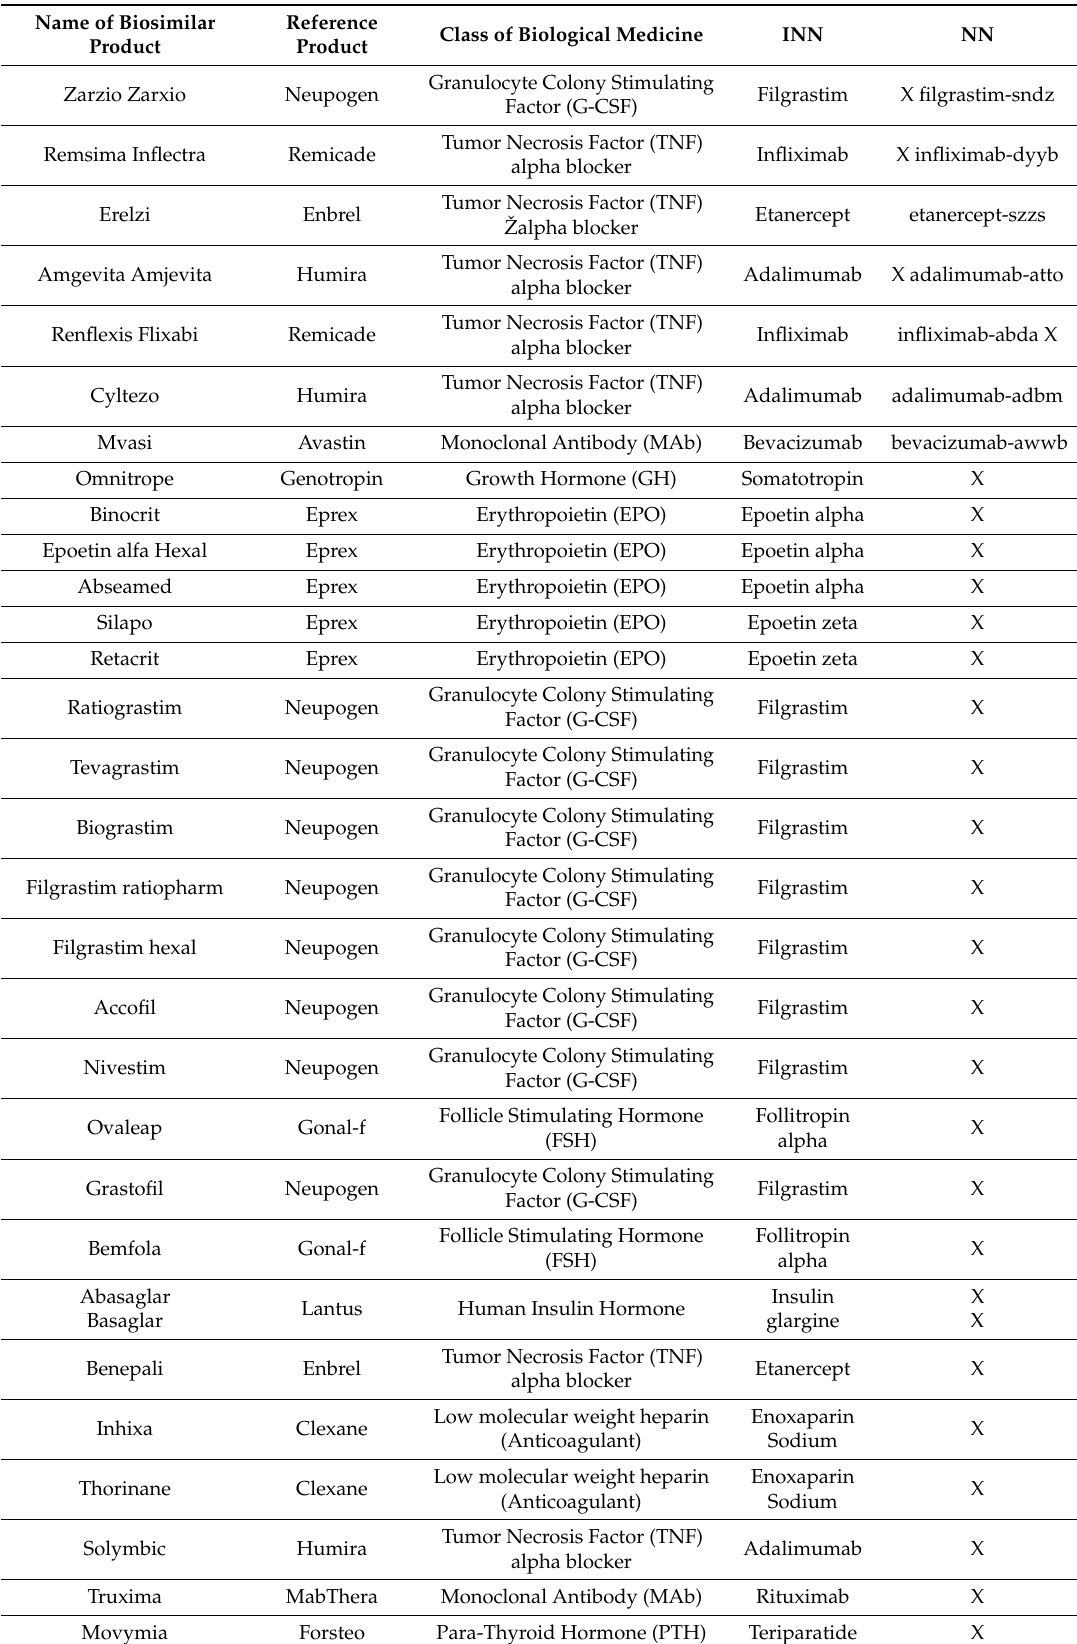
Table A2. Details of Biosimilars approved till 2019 by US FDA and